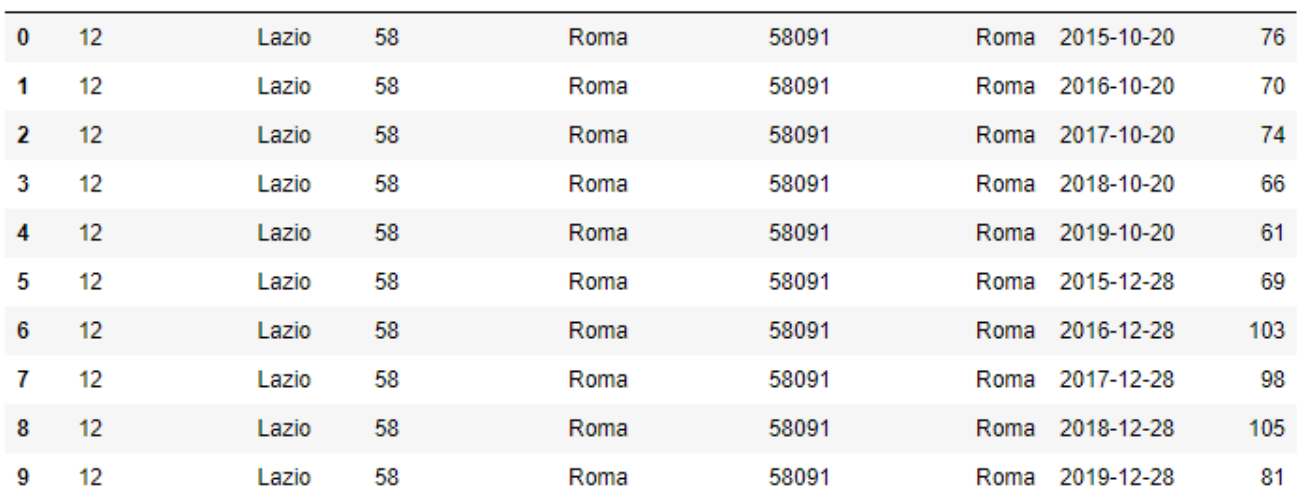
Figure 4. Extract from the ISTAT